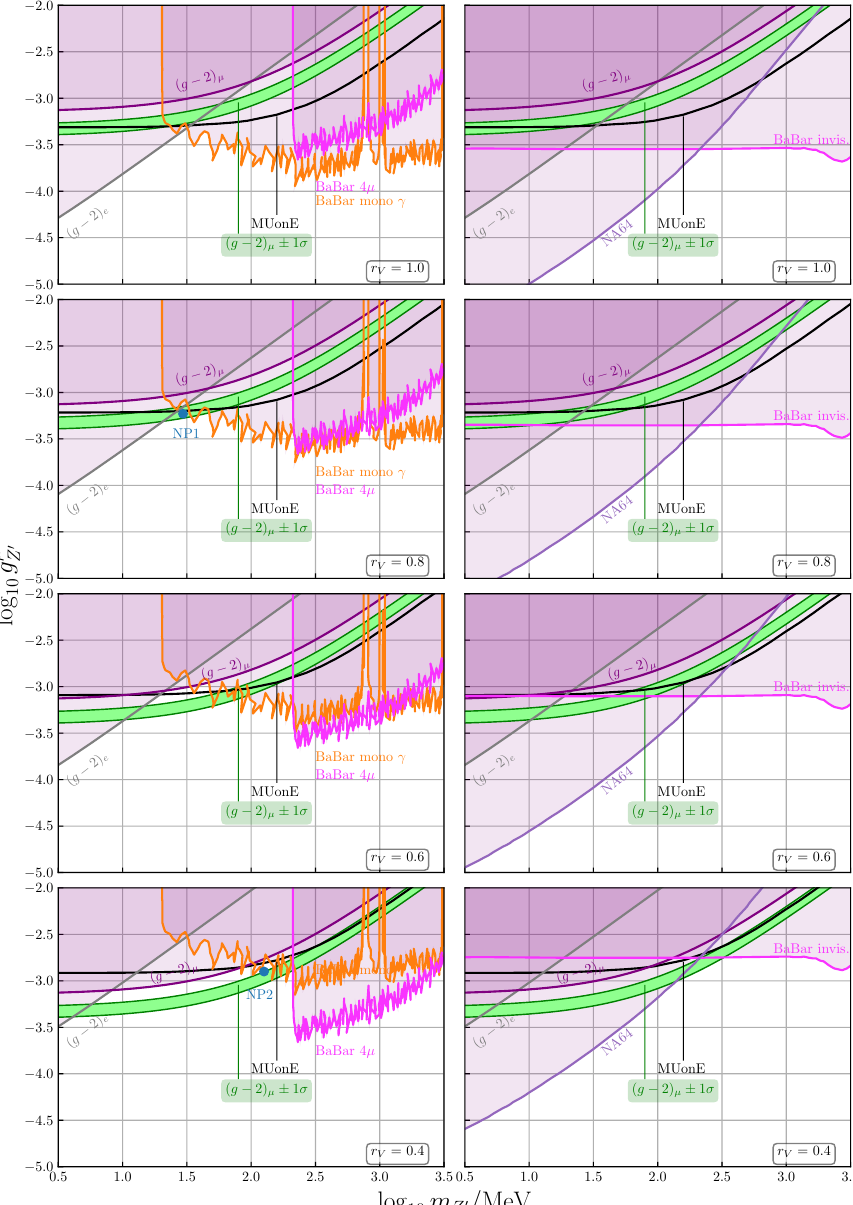
Figure 4 . Sensitivities of MUonE on a t -channel vector mediator with the interactions given in eq. (2.18) for r = 1 (upper panel), 0.8 (upper middle), 0.6 (lower middle) and 0.4 (lower). We also show the limits from electron and muon g 2, BaBar monophoton, 4 (cid:22) and invisible searches [33{35], (cid:0) and from NA64 [36, 37]. The green regions correspond to the required values of m Z 0 and g Z 0 to explain the muon g 2 anomaly at the 1 (cid:27) C.L. Depending on whether Z 0 dominantly decays into (cid:0) visible (left panel) or invisible particles (right panel), the BaBar and NA64 bounds apply di(cid:11)erently. NP1 in the left upper middle panel and NP2 in the left lower panel are two benchmark points that are shown in (cid:12)gure 5; see eq. (3.4) for the benchmark values.